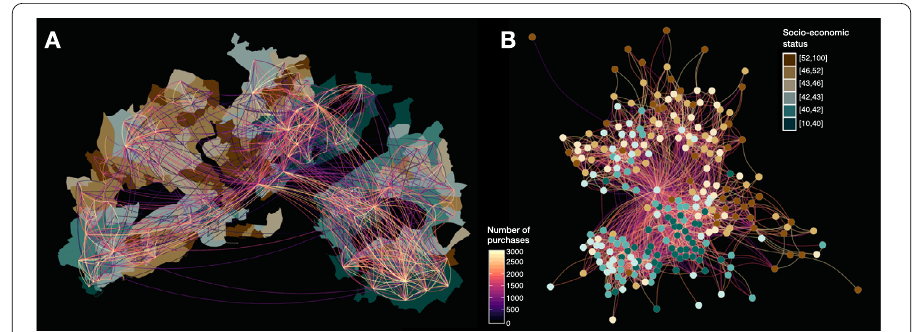
Figure 2 Neighborhood-level average diversity of purchases and Twitter mentions in the European and Latin American metropolitan areas. The size of the dots is proportional to the census population of the neighborhood and the color code indicates its wealth level. The correlation between both types of diversity is 0.45 and 0.38 for the European and Latin American case, respectively